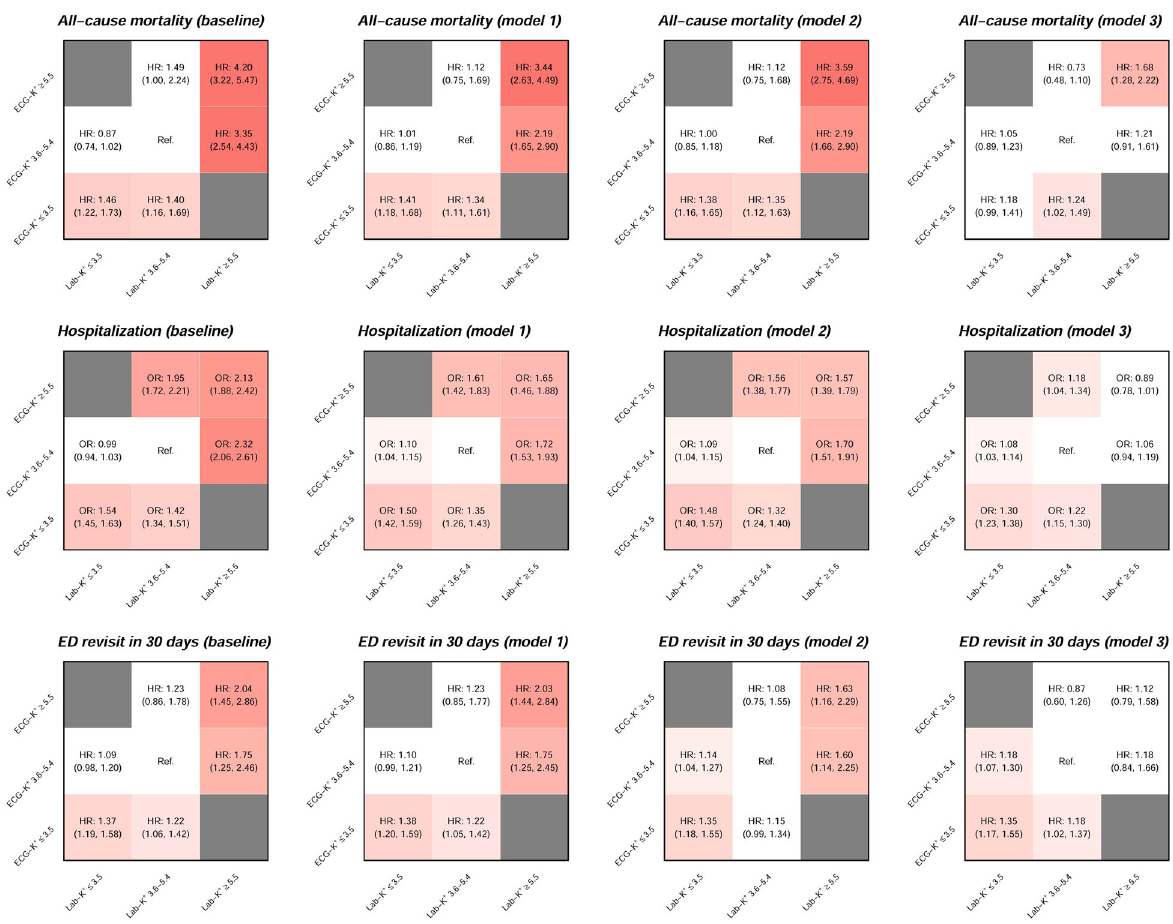
Fig. 6 Risk matrices of different ECG-K + and Lab-K + groups on adverse outcomes in combined analysis. The baseline model of combined analysis is adjusted to each hospital site and based on Cox proportional hazard model or logistic regression as appropriate for each outcome. The color gradient represents the risk of the corresponding group and non-signi fi cant results are colored white. Model 1 includes signi fi cant demographic data (All-cause mortality: gender, Age, SBP, and DBP; Hospitalization: gender, age, BMI, DBP, and smoke; ED revisit in 30 days: gender). Model 2 includes the variables in model 1 and additional signi fi cant disease histories (All-cause mortality: HLP; Hospitalization: HLP, STK, and HF; ED revisit in 30 days: DM, CAD, STK, and COPD). Model 3 includes the variables in model 2 and additional signi fi cant laboratory tests (All-cause mortality: Hb, HCO 3 , Blood pH, Na, AST, ALT, Alb, CRP, pBNP, and D-dimer; Hospitalization: WBC, Hb, PLT, HCO 3 , PH, Na, Cl, tCa, GLU, AST, CK, Alb, CRP, TnI, and D-dimer; ED revisit in 30 days: Hb and